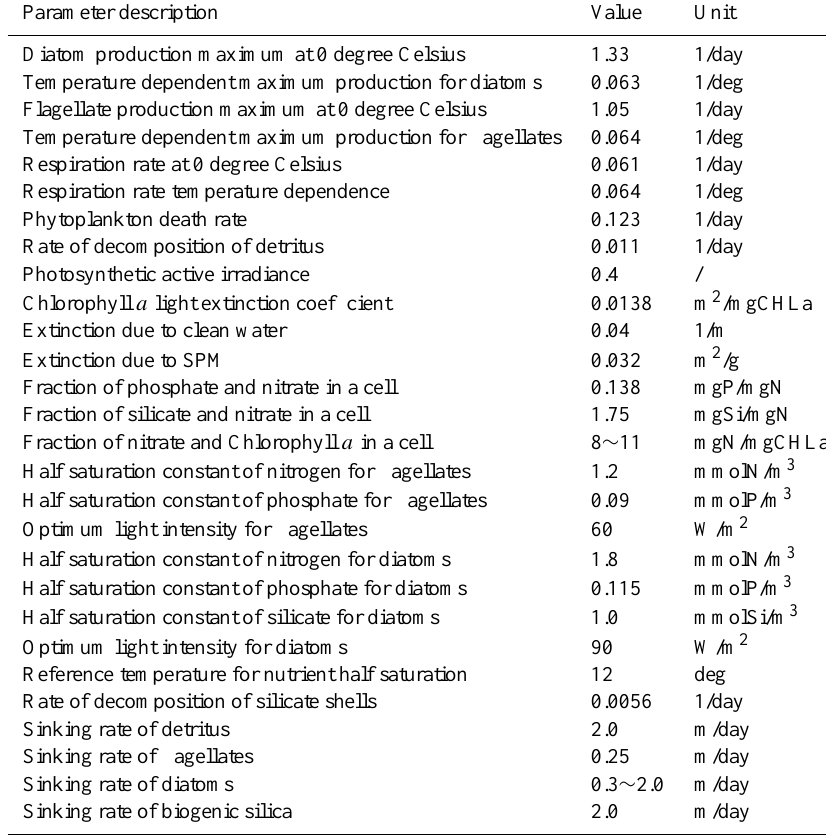
Table 1. Parameters used in the model simulation for the East China Sea. Parameter description Value Unit Diatom production maximum at 0 degree Celsius 1.33 1/day Temperature dependent maximum production for diatoms 0.063 1/deg Flagellate production maximum at 0 degree Celsius 1.05 1/day Temperature dependent maximum production for flagellates 0.064 1/deg Respiration rate at 0 degree Celsius 0.061 1/day Respiration rate temperature dependence 0.064 1/deg Phytoplankton death rate 0.123 1/day Rate of decomposition of detritus 0.011 Photosynthetic active irradiance 0.4 Chlorophyll a light extinction coefficient 0.0138 Extinction due to clean water Fraction of phosphate and nitrate in a cell Fraction of silicate and nitrate in a cell Fraction of nitrate and Chlorophyll a in a cell Half saturation constant of nitrogen for flagellates Half saturation constant of phosphate for